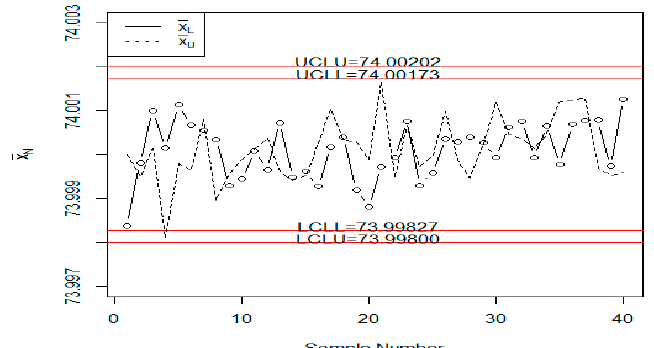
Figure 2. The Aslam and Khan (2019) chart for the summated data.